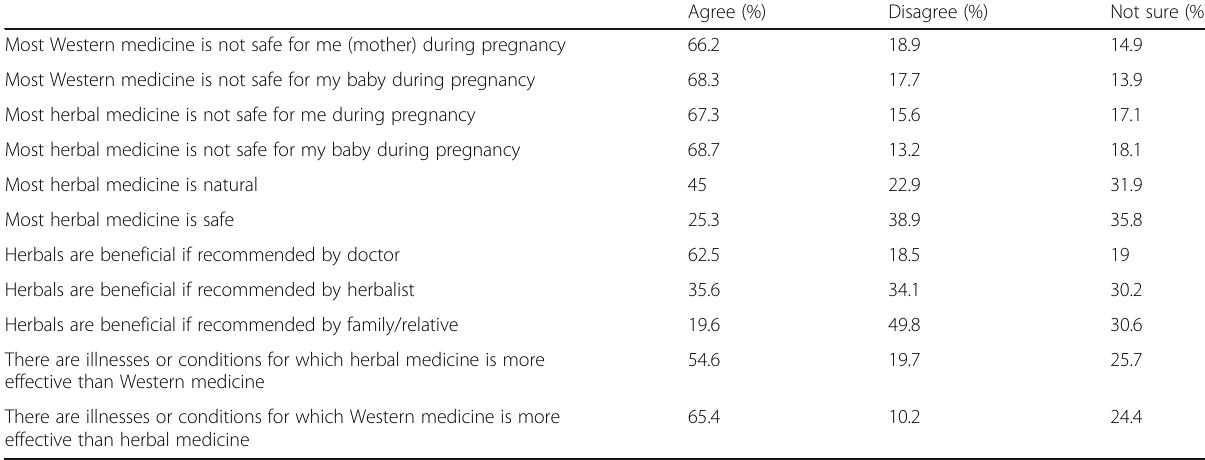
Table 5 Participants ’ thoughts about the safety of herbal and conventional medications